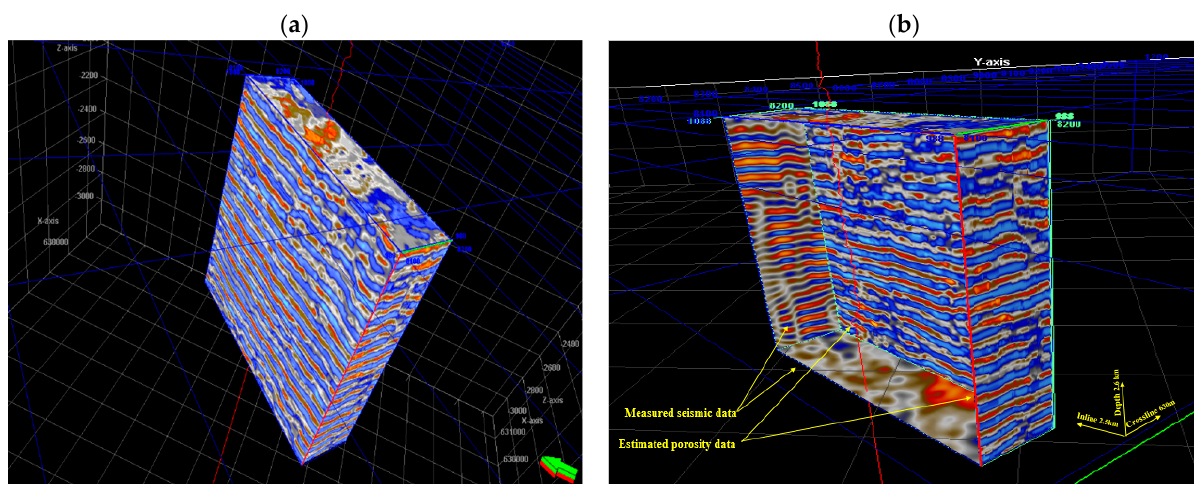
Figure 20. ( a ) 3D porosity cube around one of the subject wells estimated using the statistical Bag ensemble; ( b ) Evaluation of the estimated porosity cube (right, front, and surface walls) using a measured 3D seismic attribute, i.e., frequency filter. The satisfying agreement of the statistical model’s result with the measured data proves the reliability of the technique.